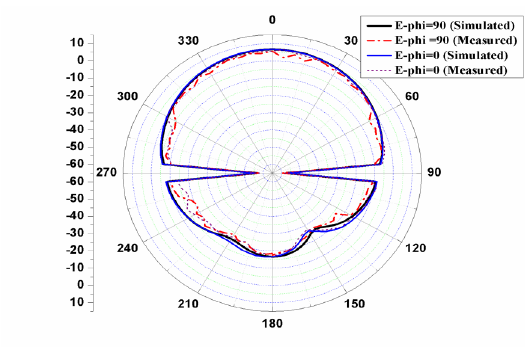
Fig. 8. 2D elevation pattern at the resonant frequency of 5.37